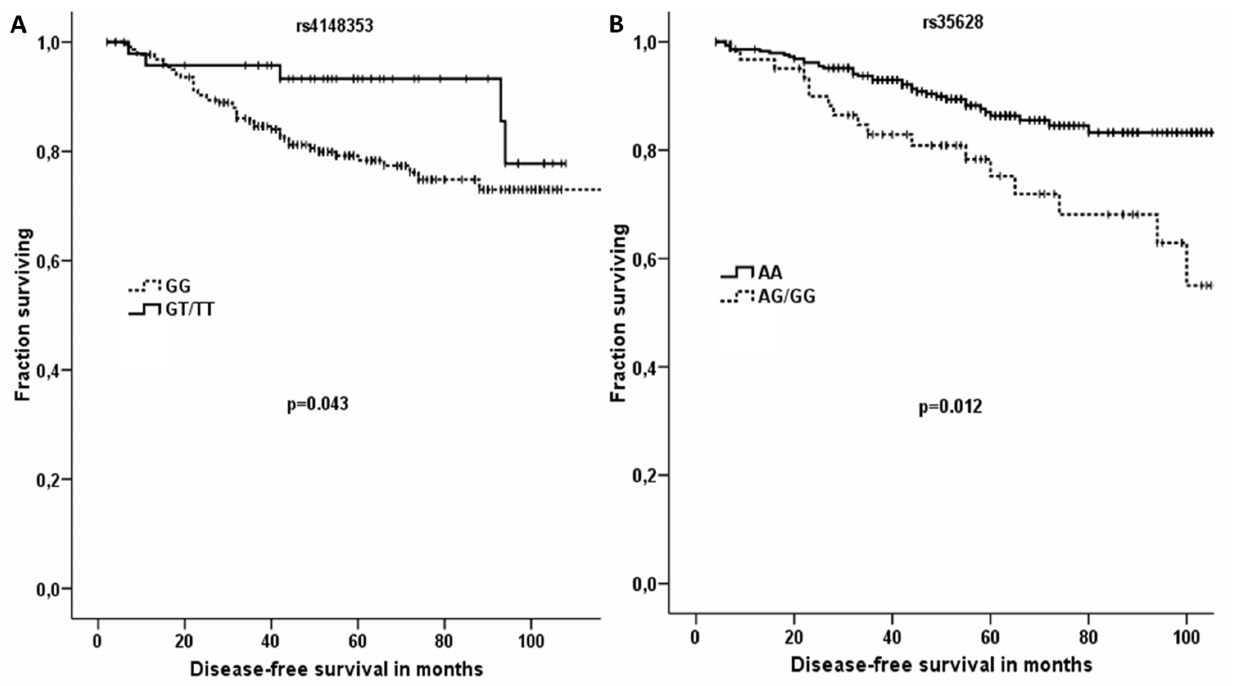
Figure 4. Significant associations between DFS of patients with breast carcinoma and SNPs in ABCC1 . Kaplan-Meier survival curves for patients treated by chemotherapy (A) and hormonal therapy (B) were analyzed by Breslow test. In part A, dashed line represents DFS of patients with the GG genotype in rs4148353, while solid line indicates that of patients with the T allele. In part B, dashed line represents DFS of patients with the G allele in rs35628 and solid line DFS of those with the AA genotype. All SNPs have been analyzed but to retain concise style only significant associations are reported.